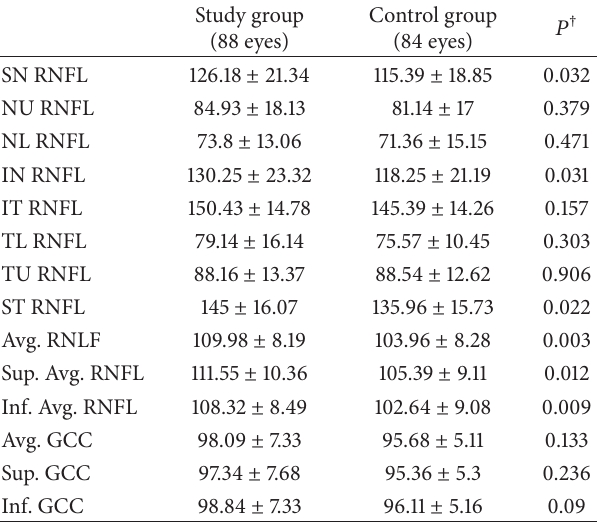
Table 2: RNFL ( 𝜇 m) and GCC ( 𝜇 m) analysis in both